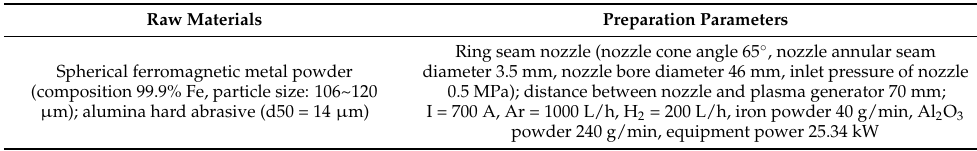
Table 1. Preparation of raw materials and preparation parameters.